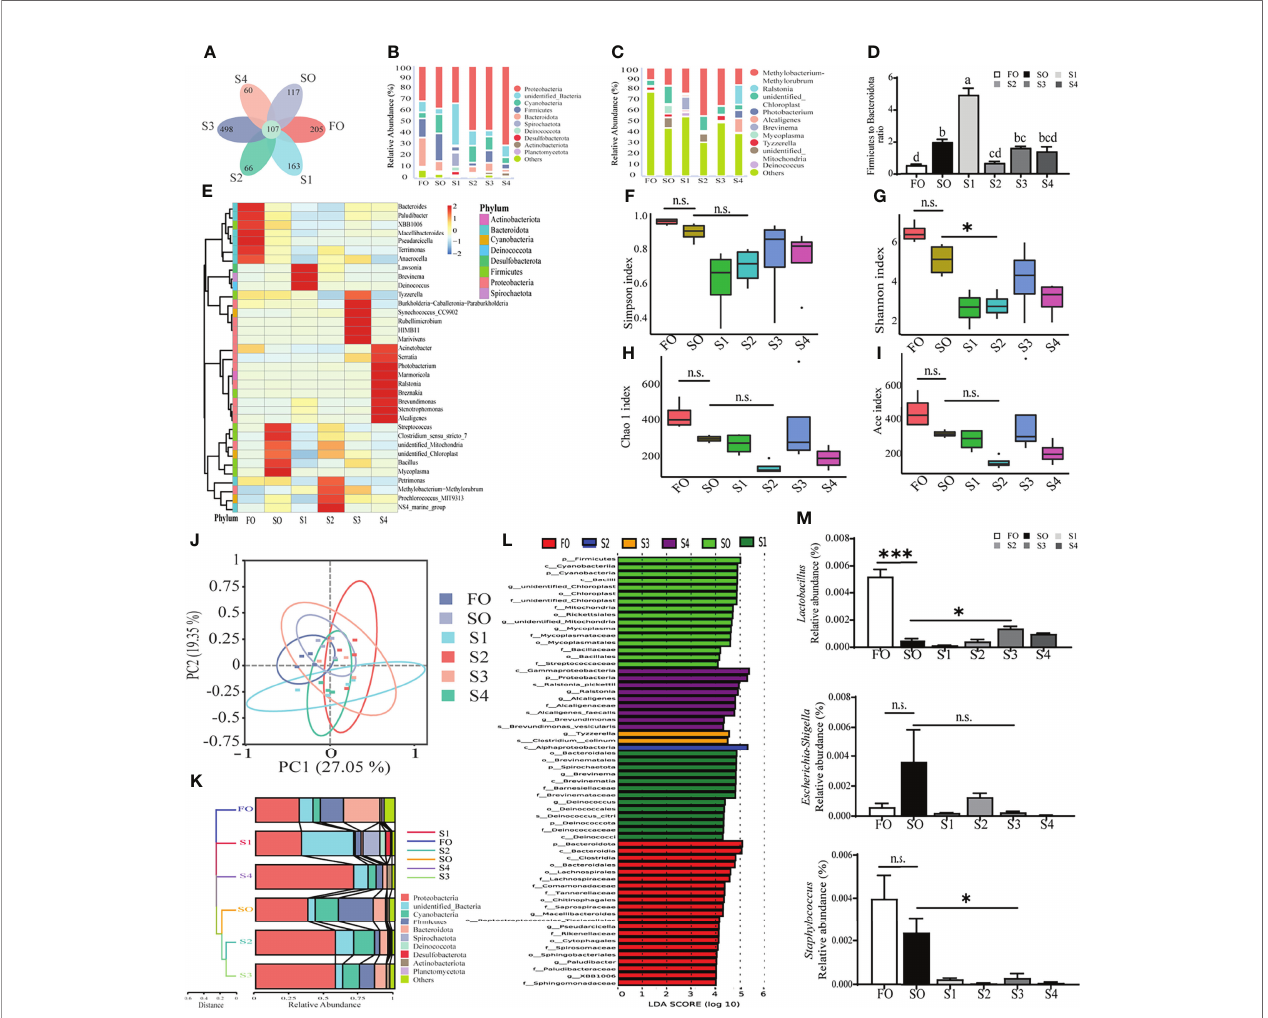
FIGURE 3 | Octanoate supplementation modulated intestinal mucosal microbiota. The pro fi le of gut mucosal microbiota (n = 4). Venn diagram (A) , the histogram of relative abundance of phylum (B) and genus (C) (Only top 10 most relative abundant bacterial phyla and genera were shown. Other phyla and genera were all assigned as ‘ Others ’ .), heatmap comparison and hierarchical clustering dendrogram based on the relative abundance of dominant bacterial genera at the phylum and genus levels (E) and the ratio of Firmicute to Bacteroidetes (n = 3) (D) were calculated to portray the fundamental structure of mucosal microbiota. Alpha diversity indices included the Simpson index (F) , the Shannon index (G) , the Chao 1 index (H), and the abundance-based coverage estimator (Ace) index (I) were calculated to compare the community diversity and richness. The beta diversity analyses were performed on the weighted Unifrac distance matrix to analyze the extent of similarities in microbial communities, including the principal coordinates analysis (PCoA) (J) and UPGMA clustering (K) . Linear discriminant analysis Effect Size (LEfSe) analysis (L) was conducted to fi nd out the biomarker with noteworthy differences between groups. The relative abundance of Lactobacillus , Escherichia- Shigella , and Staphylococcus settling on the mucosa were calculated (n = 3) (M) . Results of alpha diversity indices and the relative abundance of Lactobacillus , Escherichia-Shigella , and Staphylococcus were analyzed using independent t-test (n.s., No signi fi cant; P ≥ 0.05, *0.01 ≤ P < 0.05, *** P <